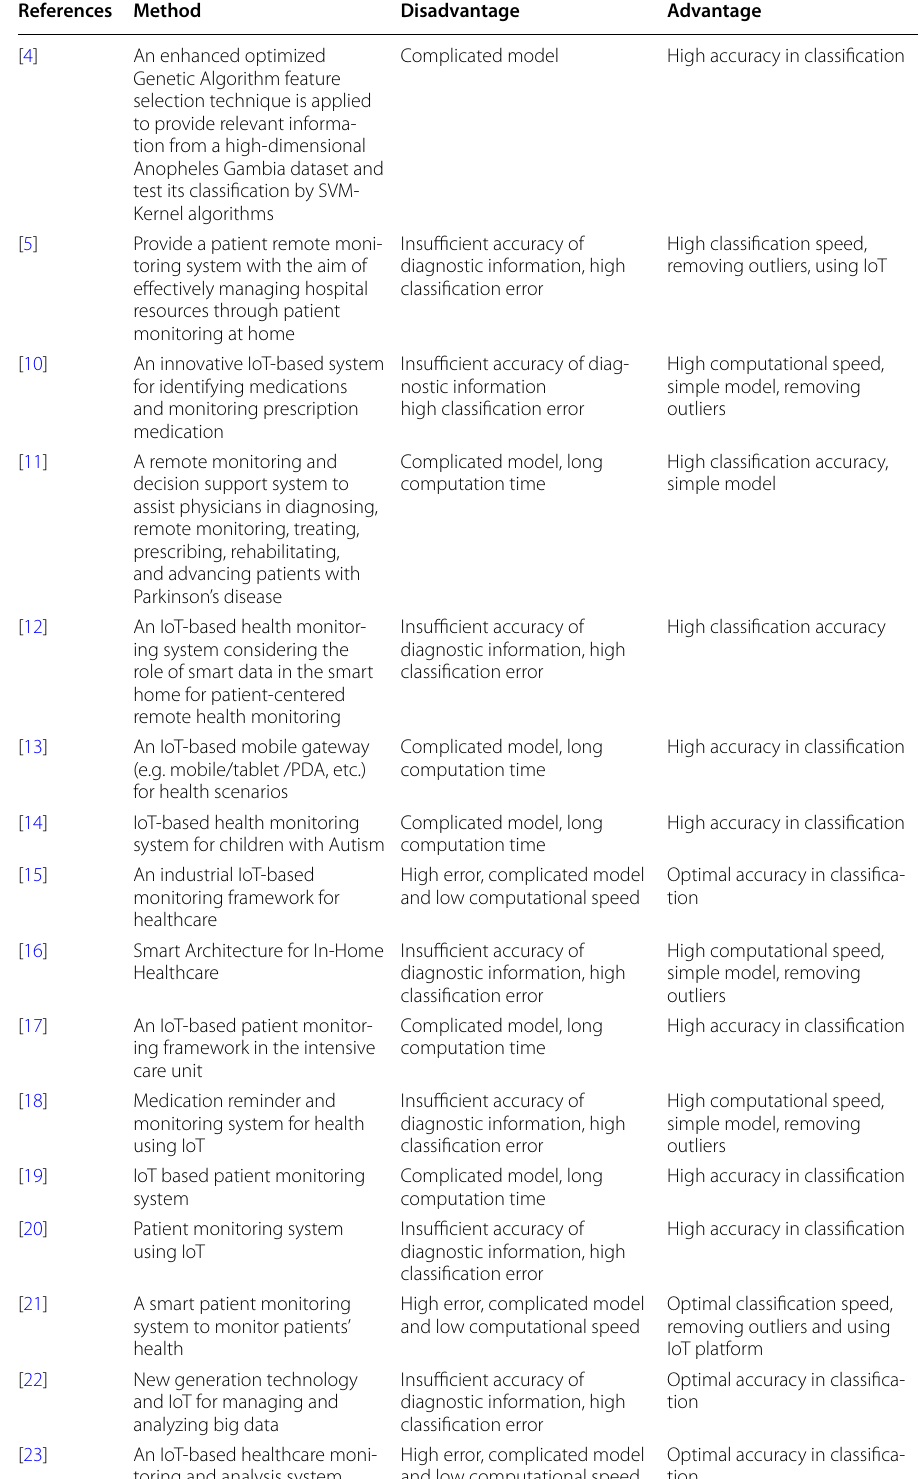
Table 1 Comparing the advantages and disadvantages of previous methods References